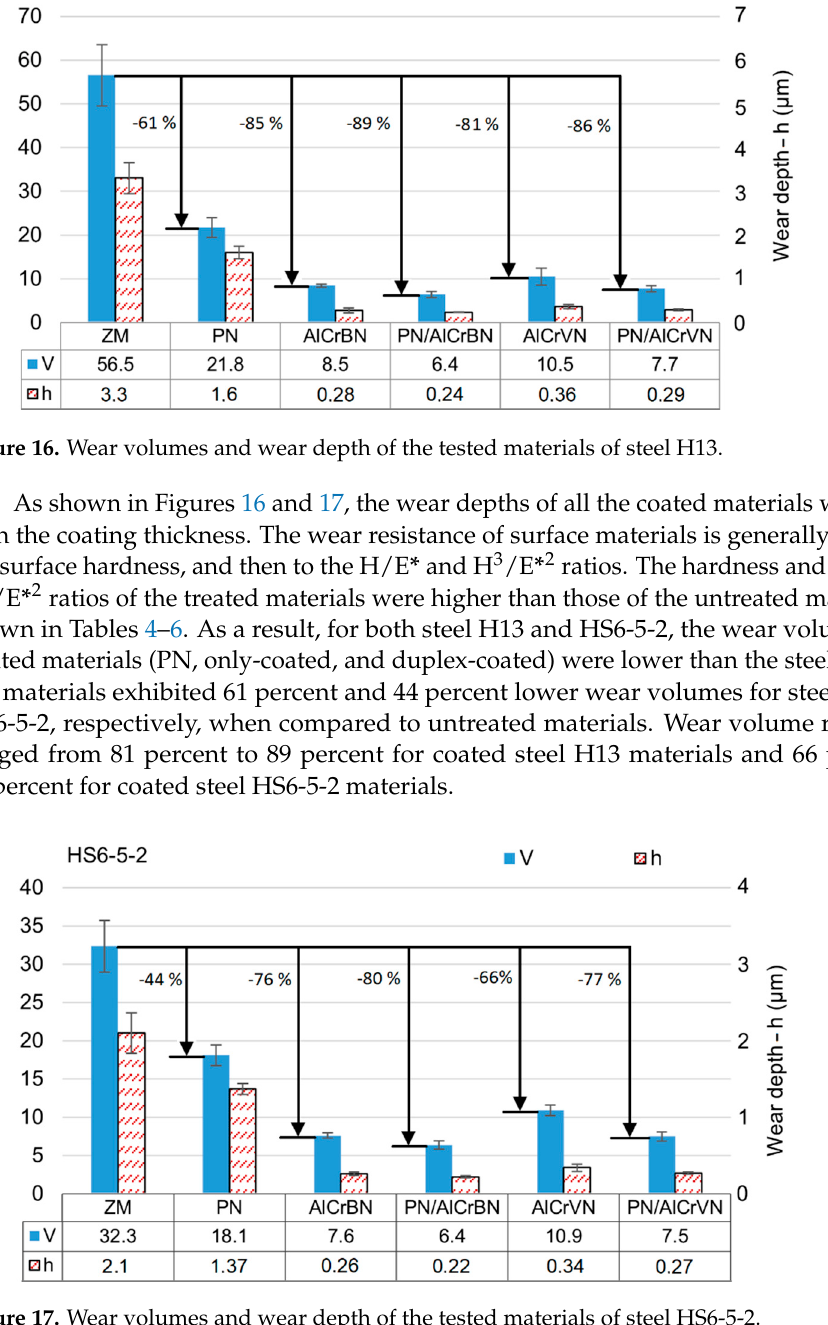
15 of 19 Figure 15. Features and cross-sectional of wear tracks of tested materials steel HS6-5-2.